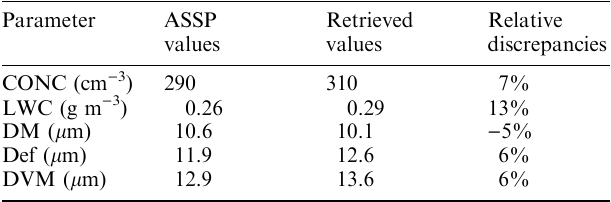
Fig. 3. Mean scattering phase function measured by the Polar Nephelometer over the 10-s period labelled B1 in Fig. 2. The scattering phase function obtained by the Mie theory and calculated with the ASSP mean droplet spectra also averaged on the B1 period is also represented